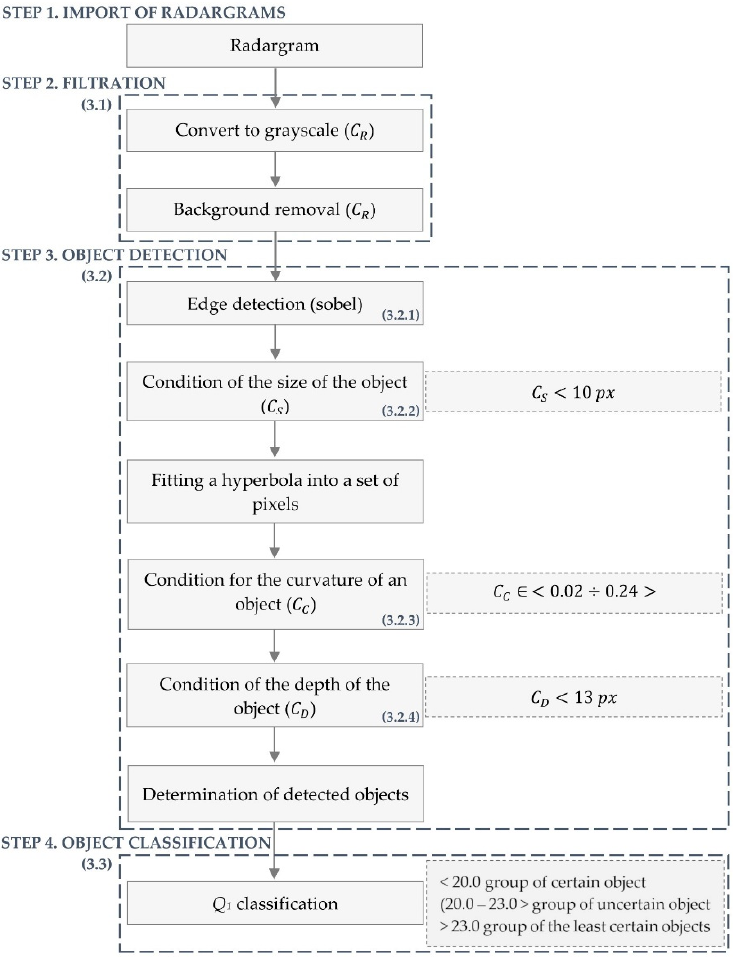
Figure 6. Diagram of the proposed Method 1.